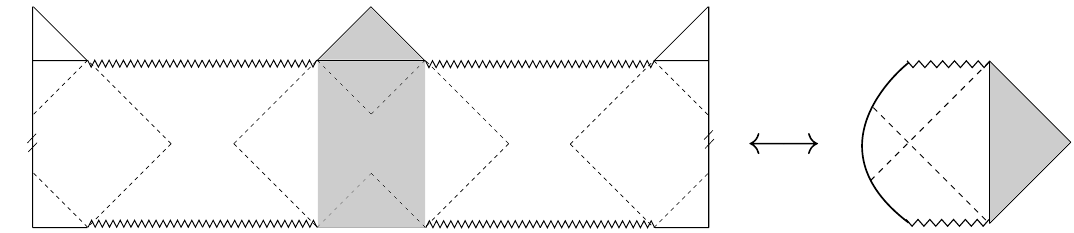
Figure 15. On the right we have a pure-state black hole with an end-of-the-world brane behind the horizon. This means that the single wing system (plus boundary) encodes the entire bulk, and has fine-grained entropy S = 0 . This corresponds to unfreezing one of the two frozen regions in the TFD in figure 14. It is analogous to a single frozen hat region in dS, shown on the left. In this case the theory in the hat has fine-grained entropy S = 0 and encodes the entire universe on its own.